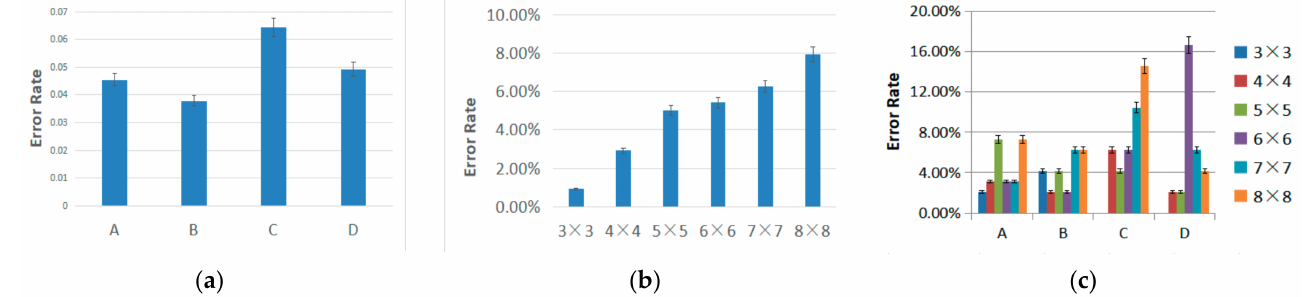
Figure 12. The error rate of comparative Experiment 1. The error bars represent a 95% confidence interval: ( a ) average error rate with different regions; ( b ) average error rate with different target size levels; and ( c ) average error rate for different target size levels under different regions (A, B, C, and